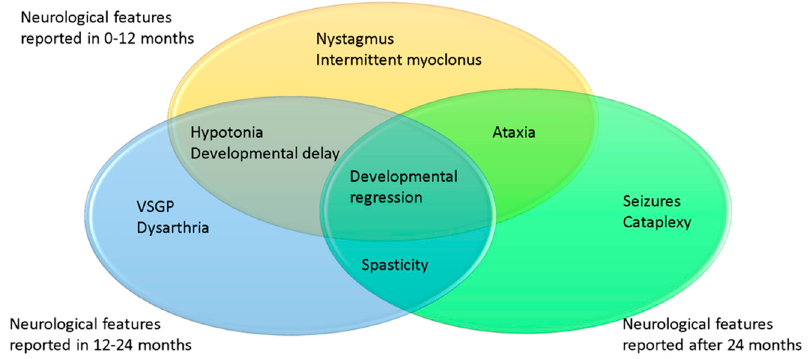
Figure 6. Age of onset of presentation for neurological symptoms in NPC2 patients. In yellow 0–12 months, blue 12–24 months, green 24+ months.